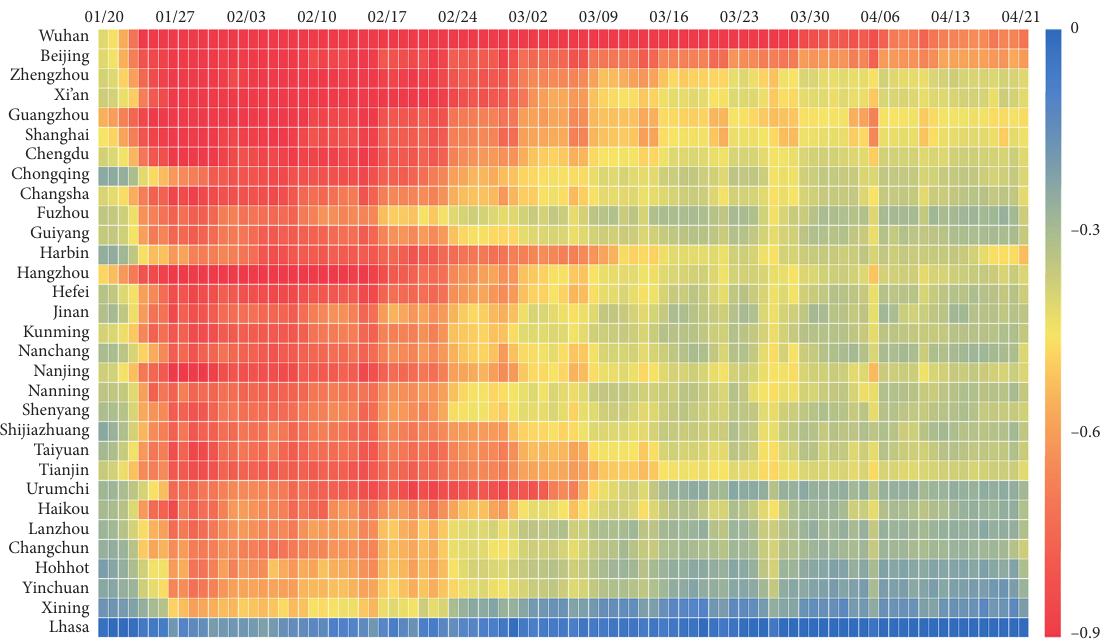
Figure 5: Heatmap of the daily HIC in key cities in China.